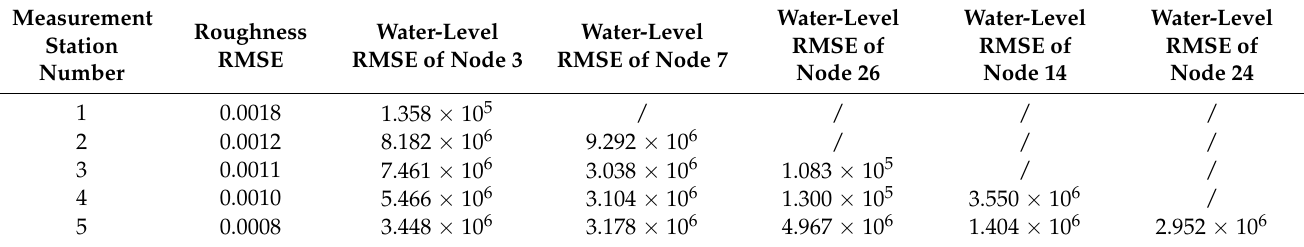
Table 1. RMSE values of roughness and water level at the measurement